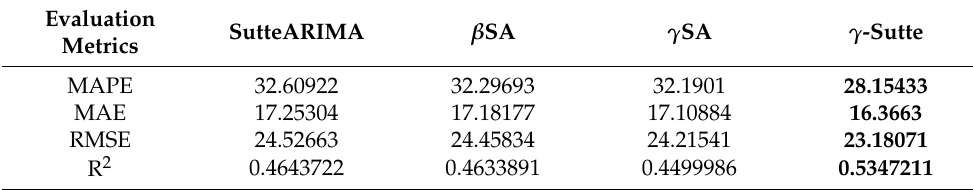
Figure 4. 2021 prediction chart of No. 6 Naphtha Cracking Complex regions. ( a ) Ensemble model; ( b ) Single time series. Table 4. Results of the ensemble model in No. 6 Naphtha Cracking Complex regions.